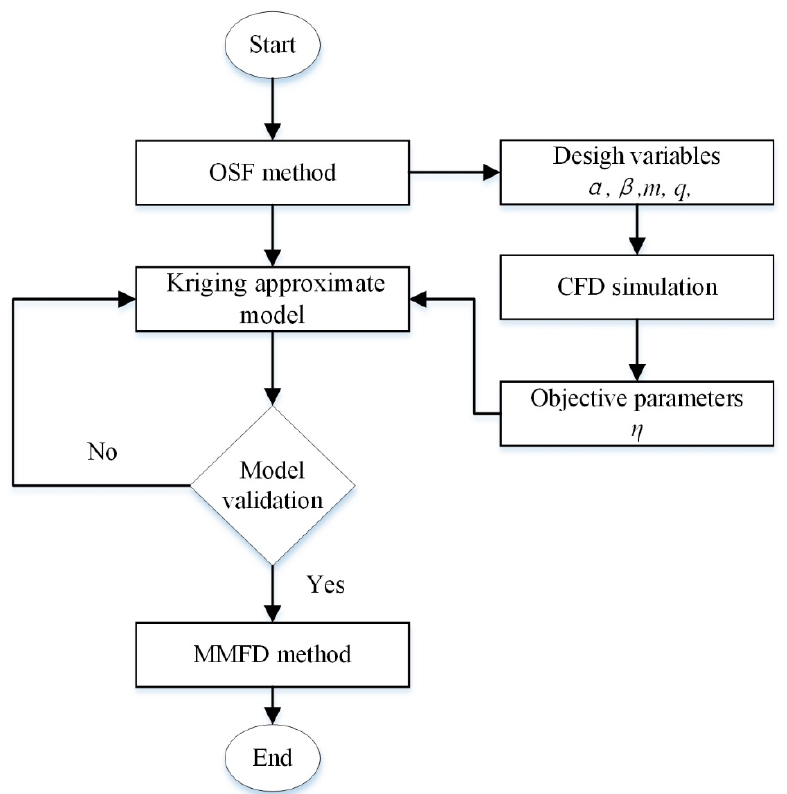
Figure 4. The optimization flow. MMFD: modified method of feasible directions; OSF: optimal space filling design.